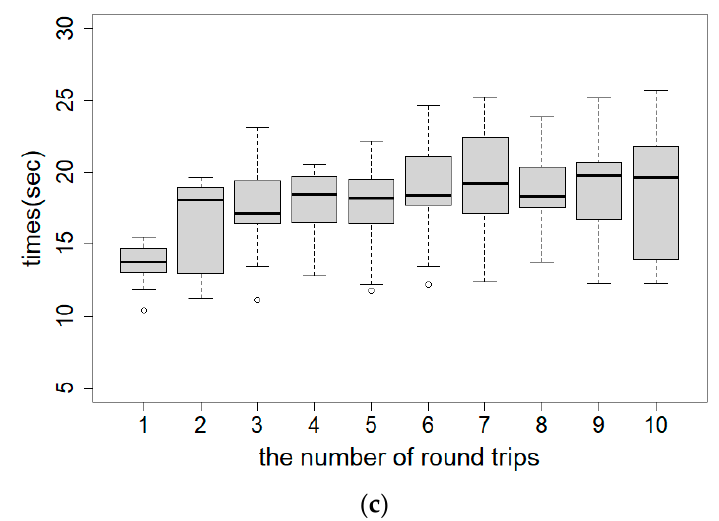
Figure 5. Box and whisker plots (median, first and third percentiles, range) display the lap times over the number of round trips in three groups. ( a ) Not equipped with the LEXO-W without a 15 kg load (baseline group); ( b ) not equipped with the LEXO-W with a 15 kg load (load-carrying group); ( c ) equipped with the LEXO-W with a 15 kg load (robot-assisted group).